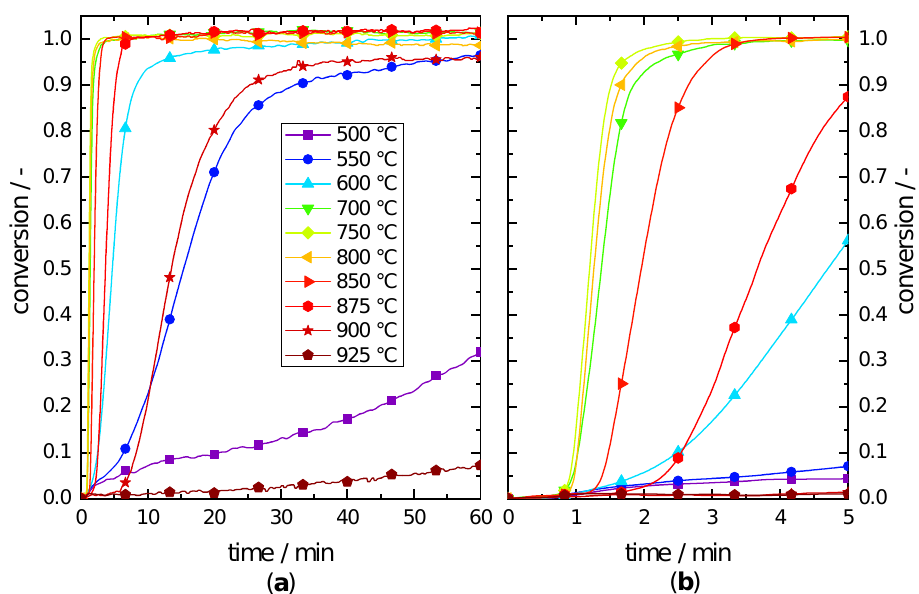
Figure 4. Oxidation conversion of manganese–iron oxide particles during isothermal measurements with an oxygen partial pressure of 210hPa in a thermogravimetric analyzer. ( a ) Overview of the reaction conversion of the isothermal section. ( b ) Enlarged plot of the reaction conversion during the first 5min of the isothermal section.